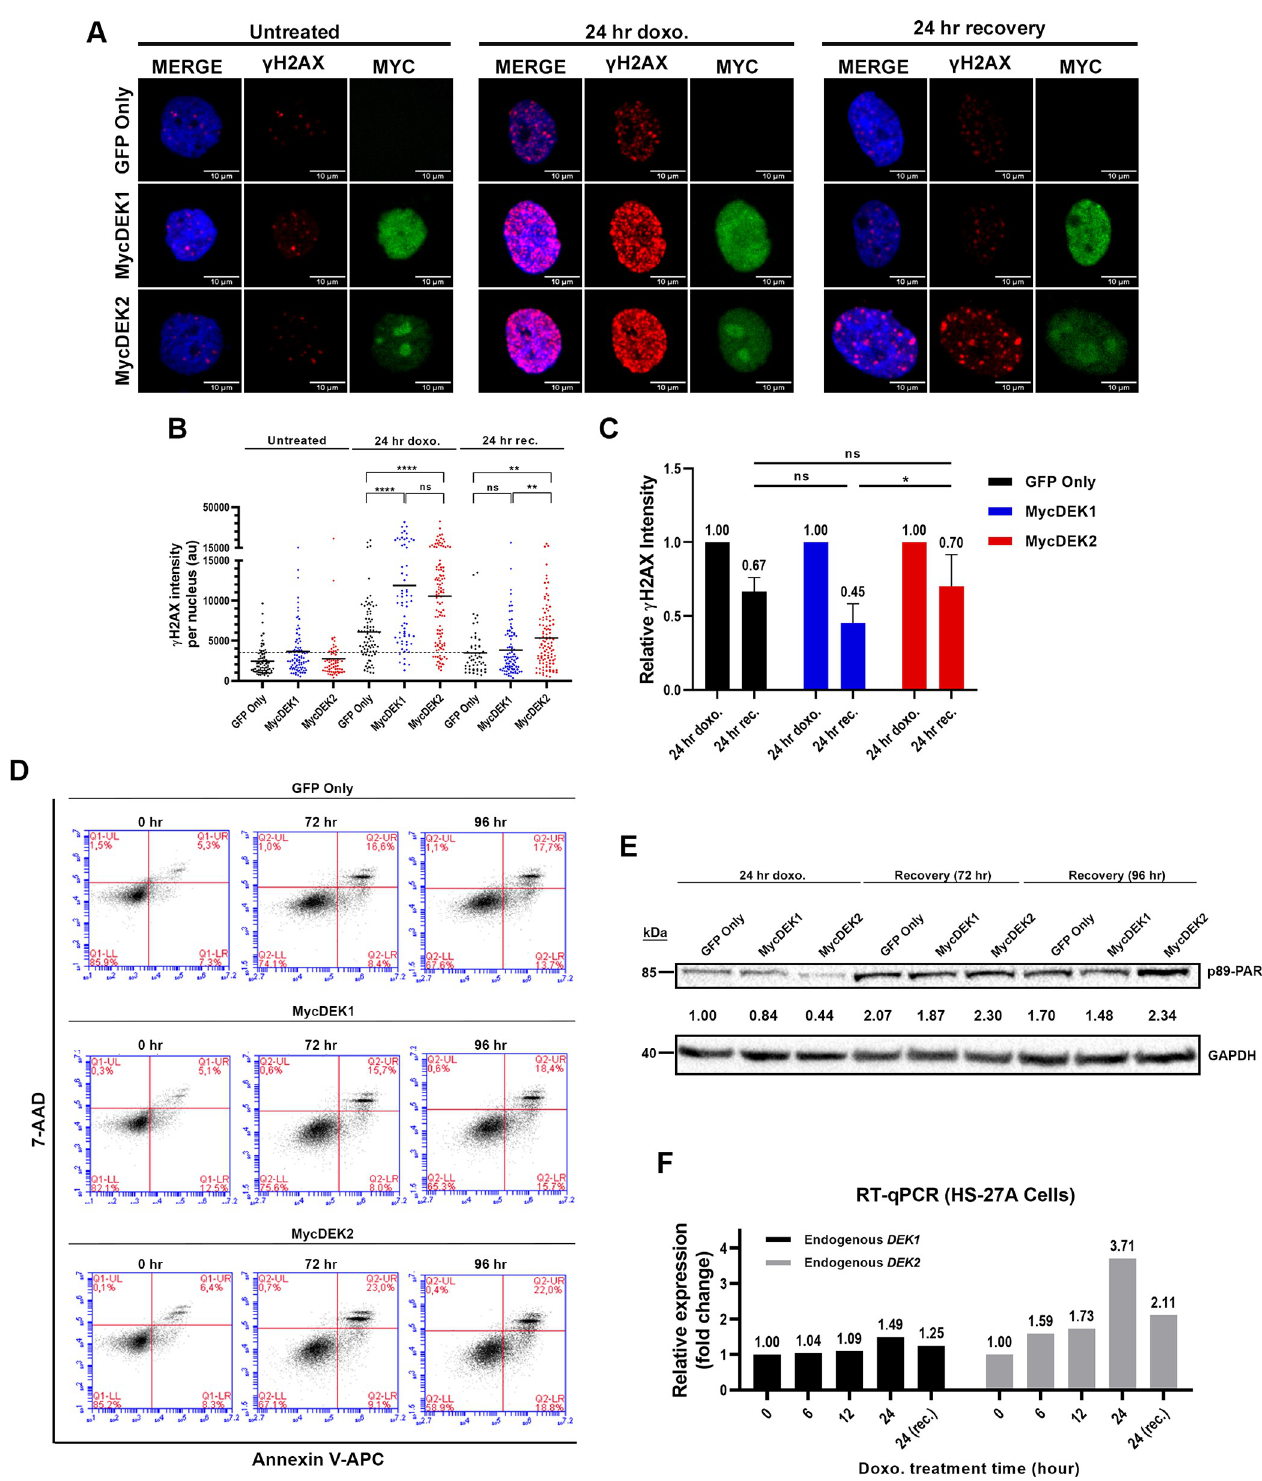
Fig 5. Effect of DEK1 or DEK2 overexpression on DNA repair efficiency. (A) MycDEK1 (anti-Myc antibody, green in middle panels), MycDEK2 (anti-Myc antibody, green in lower panels), and γ H2AX expression (anti- γ H2AX antibody, red) were determined by immunocytochemistry and representative pictures captured by confocal microscope were shown in the vehicle (untreated), doxorubicin (24 hr doxo.) and recovery (24 hr recovery) groups (40X, with oil). DAPI (blue) labels the nucleus. (B) A graphic of one representative experiment shows the anti- γ H2AX staining intensity per nucleus (Y-axis) in each group that was